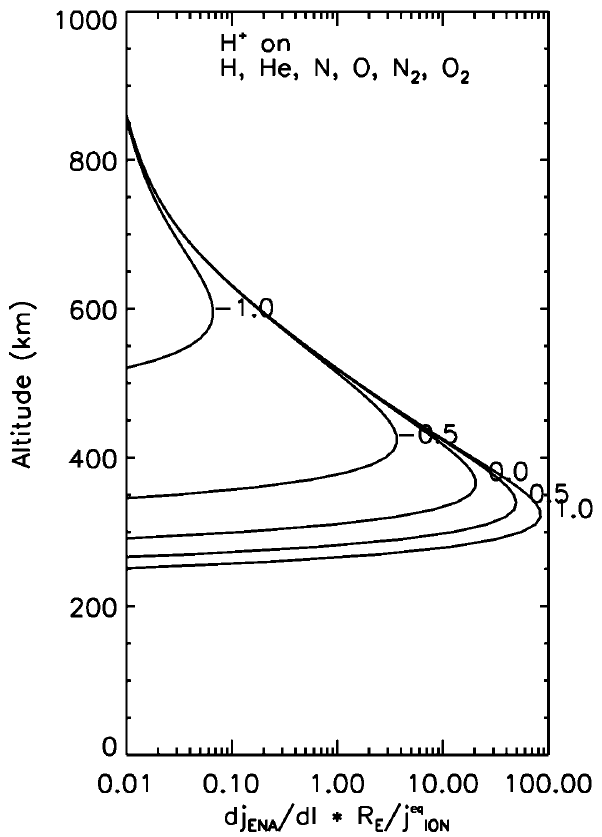
Fig. 16. The ENA production function ∂j ENA / ∂ l · R E / j eq text) for 40keV H + ions plotted as a function of altitude for various values of the pitch angle, assuming a six-component exosphere (H, He, N, O, N 2 and O 2 ).